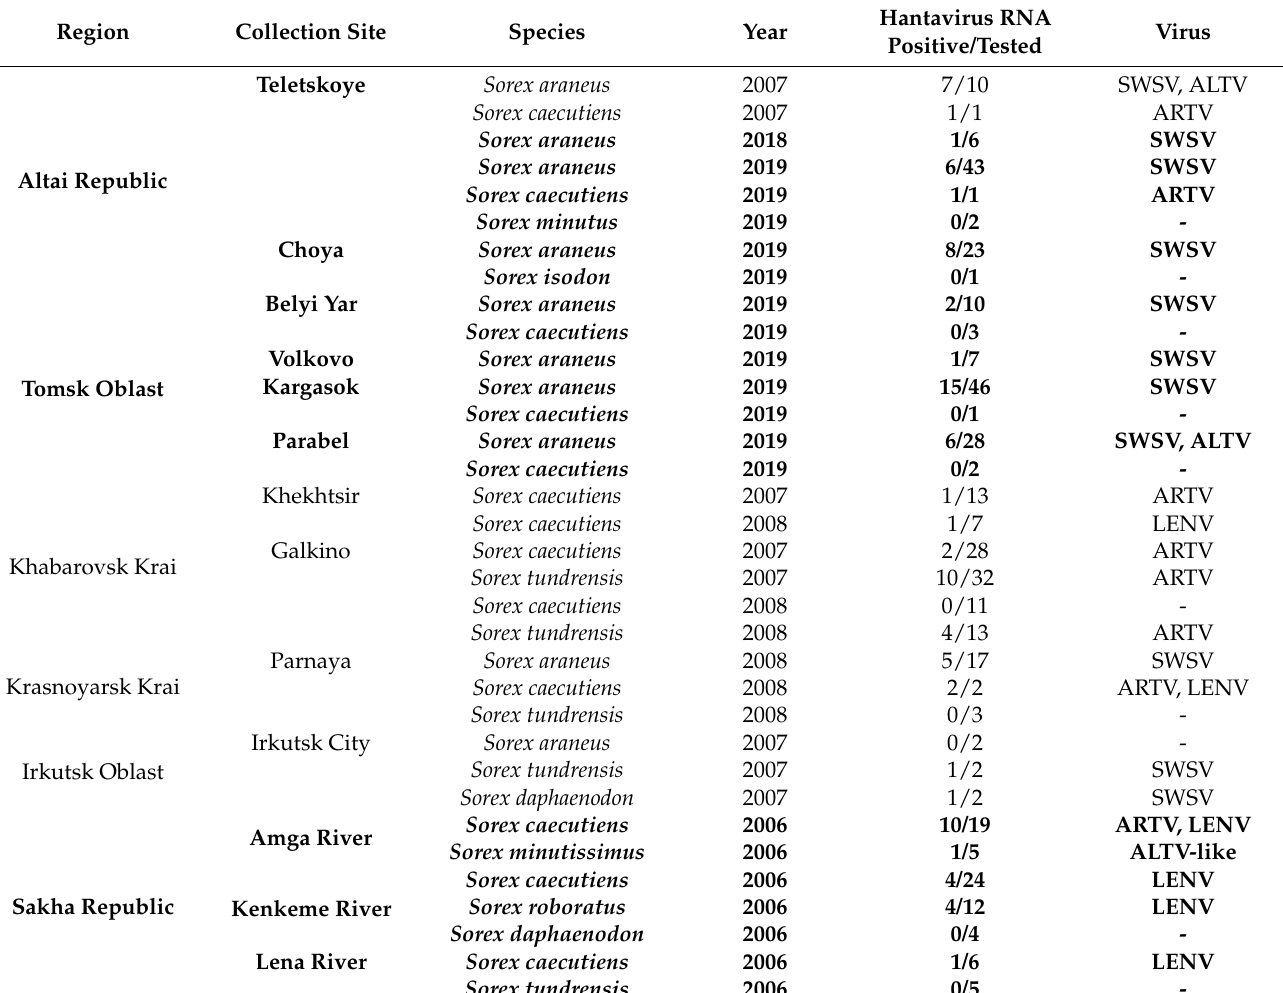
Table 1. Prevalence of hantavirus RNA and identified viruses in Sorex shrews by species and location in Asian Russia.